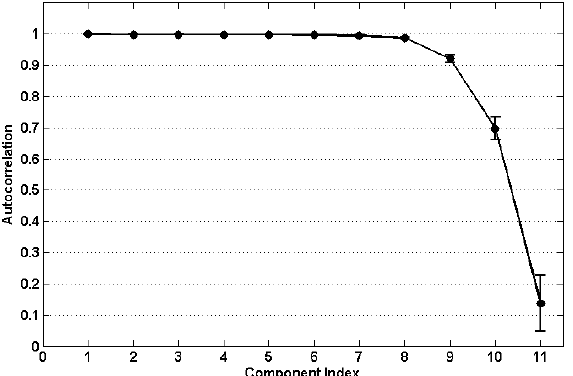
Figure 9. The averaged autocorrelation of the eleven EEMD-CCA components over all 21 ictal EEG